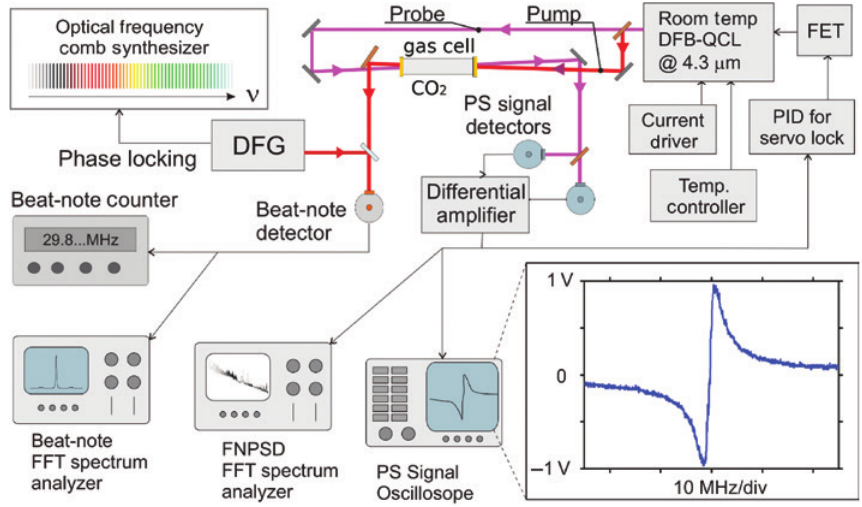
Figure 3: Polarization-locking setup. The probe beam gives the signal used for the frequency locking. The pump beam is also used for the beat-note detection and the frequency counting. PS, polarization spectroscopy; DFG, comb-referenced single-frequency difference-frequency generation; FET, field-effect transistor; FFT, fast Fourier transform. Adapted with permission from [51], copyright